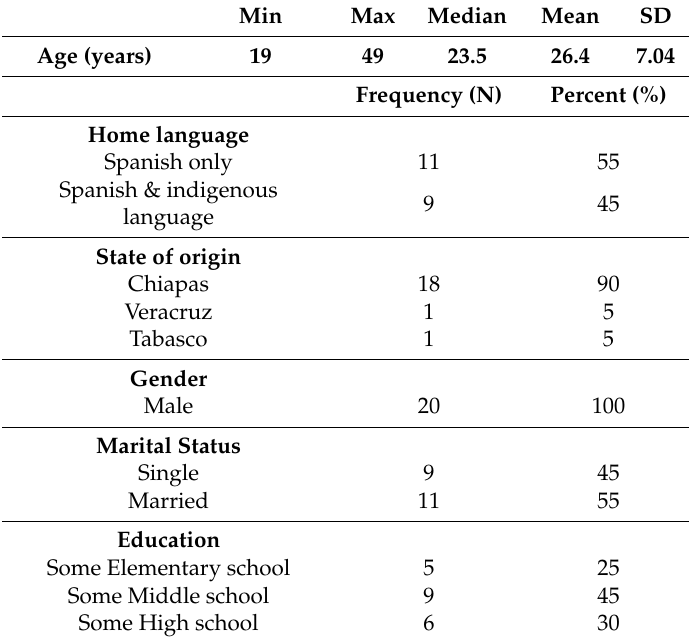
Table 2. The socio-demographic characteristics ( N =